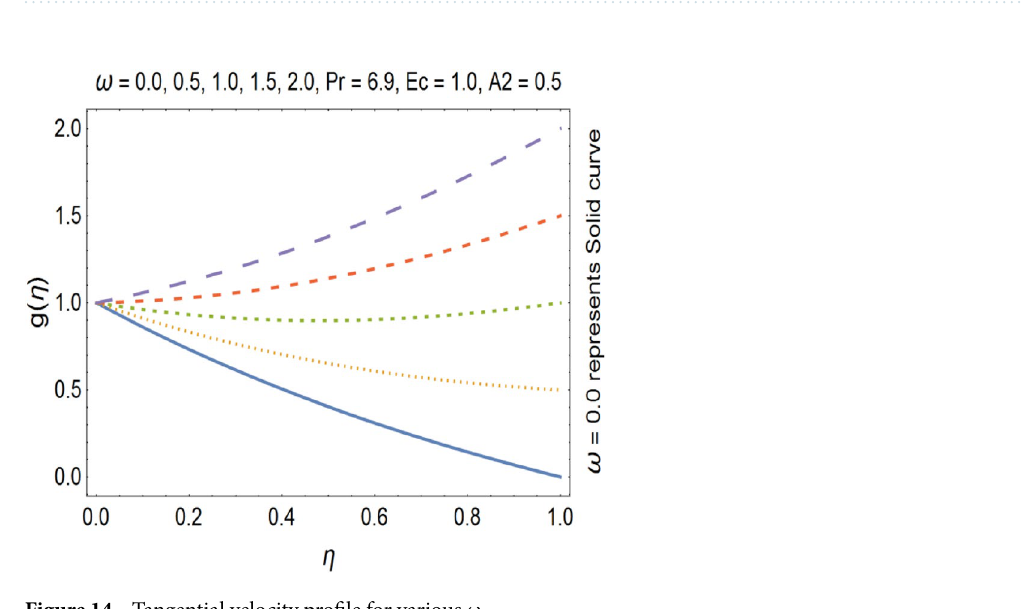
Figure 13. Tangential velocity profile for various A1.